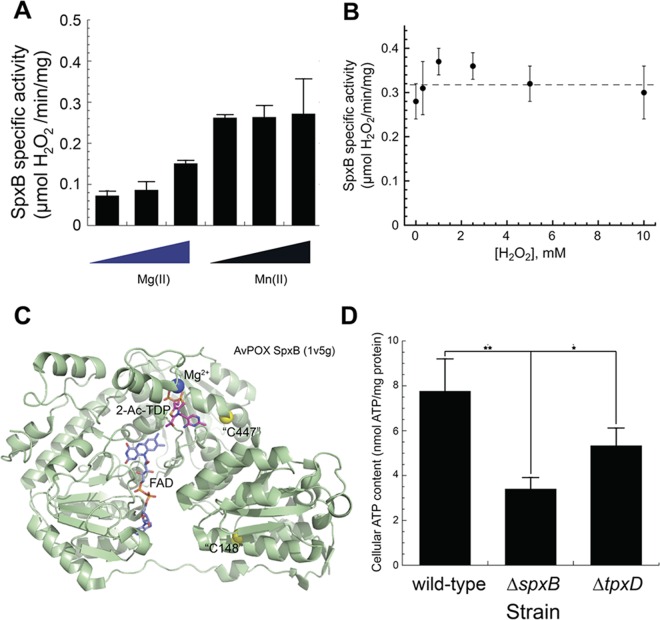
S. pneumoniae SpxB activity is resistant to H2O2 exposure. (A) Specific activity of S. pneumoniae SpxB in the presence of 0.5, 1, and 2 mM Mg(II) or Mn(II). (B) Specific activity of S. pneumoniae SpxB after incubation with H2O2 (0 to 10 mM) at pH 7.0. The average activity is 0.32 ± 0.04 µmol·min−1·mg−1 protein (dashed line) and is independent of H2O2 over this concentration range. (C) Structure of Aerococcus viridans (pyruvate oxidase [AvPOX] subunit [1V5G; 69% identity, 82% similarity to S. pneumoniae SpxB]) (94) highlighting the FAD and TPP cofactors, the latter as the 2-acetyl-thiamine diphosphate (2-Ac-TDP) reaction intermediate, the Mg(II) ion, and the approximate position of two Cys (C148 and C447, based on S. pneumoniae residue numbering) not found in A. viridans pyruvate oxidase. C447 is quite close to the active site, while C148 is sulfonylated in cells (Table S2D). Mg(II) is octahedrally coordinated by D439, N466, D468 O′ (all conserved in the S. pneumoniae SpxB), a water molecule, and substrate. (D) Excess proteome sulfenylation in a ΔtpxD mutant (Fig. 4) inhibits ATP generation in S. pneumoniae. The ATP content (nanomoles of ATP per milligram of protein) of mid-log-phase (OD620 ≈ 0.3) cultures in BHI under microaerophilic conditions was measured for the wild-type, ΔspxB, and ΔtpxD strains. ATP content was found to be significantly lower for both ΔspxB (P < 0.01) and ΔtpxD (P < 0.05) strains based on 2-tailed unpaired t tests.